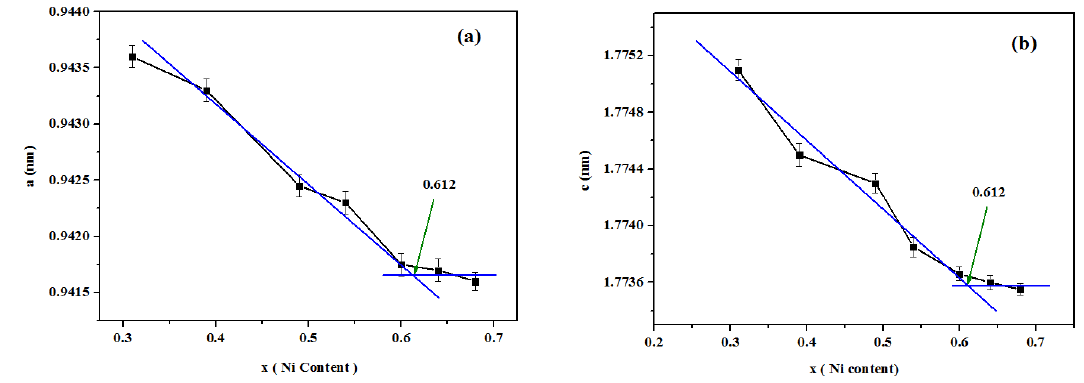
Figure 11. Variation of ( a ) the lattice parameter a and ( b ) lattice parameter c of Co 1 − x Ni x In 2 on Ni content.